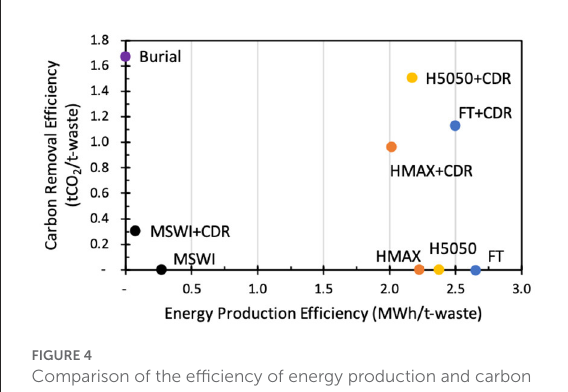
FIGURE4 Comparison of the efficiency of energy production and carbon removal for each process studied. Efficiency here is defined as the amount of energy (MWh) or carbon removals (tCO 2 ) generated per ton of waste (MSW or forestry